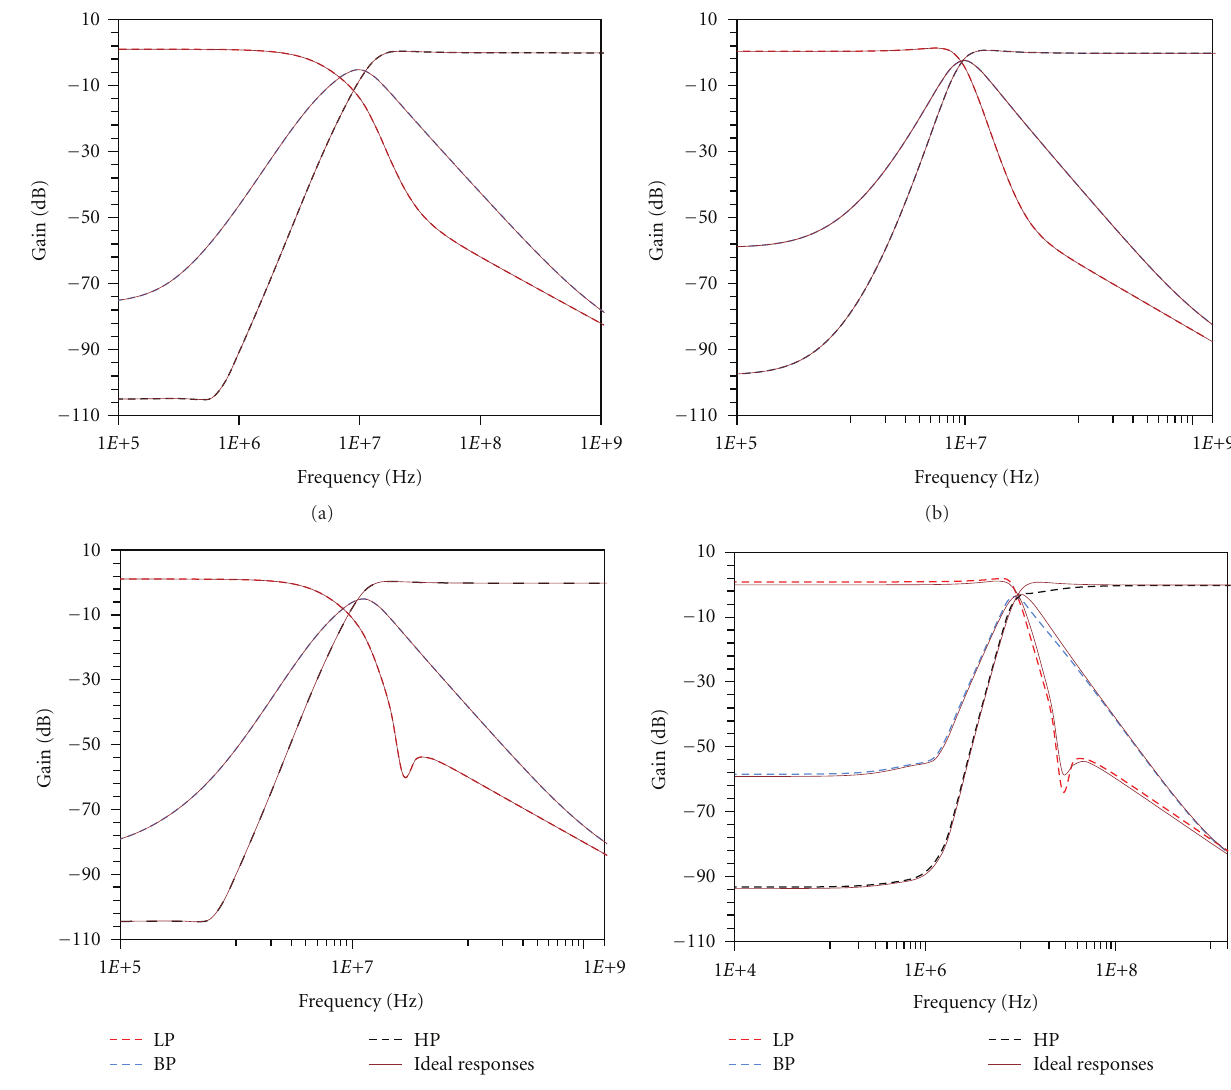
Figure 7: Simulated magnitude responses of standard filter functions of MFFs of Figure 6. (a) MFF1 (b) MFF2 (c) MFF3 (d) MFF4.